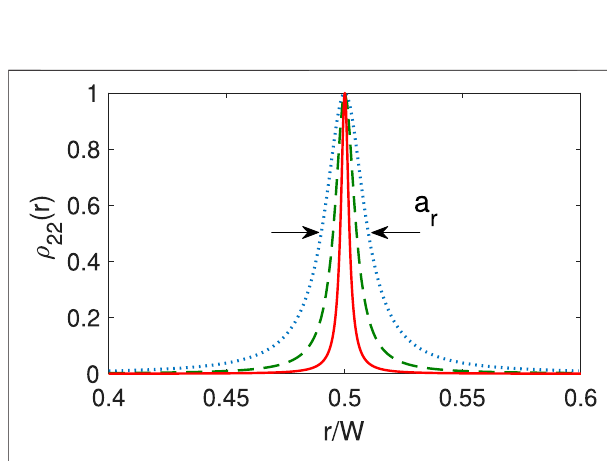
FIGURE 3 | Steady population distribution ρ 22 ( r ) along the radial direction r for κ p = Ω p 0 / Ω c10 = 0.01 (blue-dotted), 0.005 (green-dashed), and 0.002 (red-solid). a r istheFWHM,whichcharacterizes thespatial resolutionof localization. Here, we use κ c =